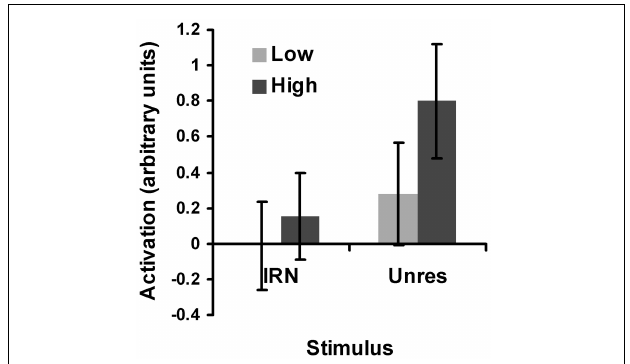
FIGURE 6 | Plot of the salience analysis results for IRN and for unres within the spherical pitch ROI. “Activation” refers to the average beta weights: a numerical measure of the effect size. The low salience conditions are represented by the light gray bars and the high salience conditions are represented by the dark gray bars. For the low-salience IRN condition, IRNo 4 has been subtracted from IRN 4 and for the high-salience condition, IRNo 64 has been subtracted from IRN 64 to remove the effects of slow modulation. Error bars represent 95% confidence